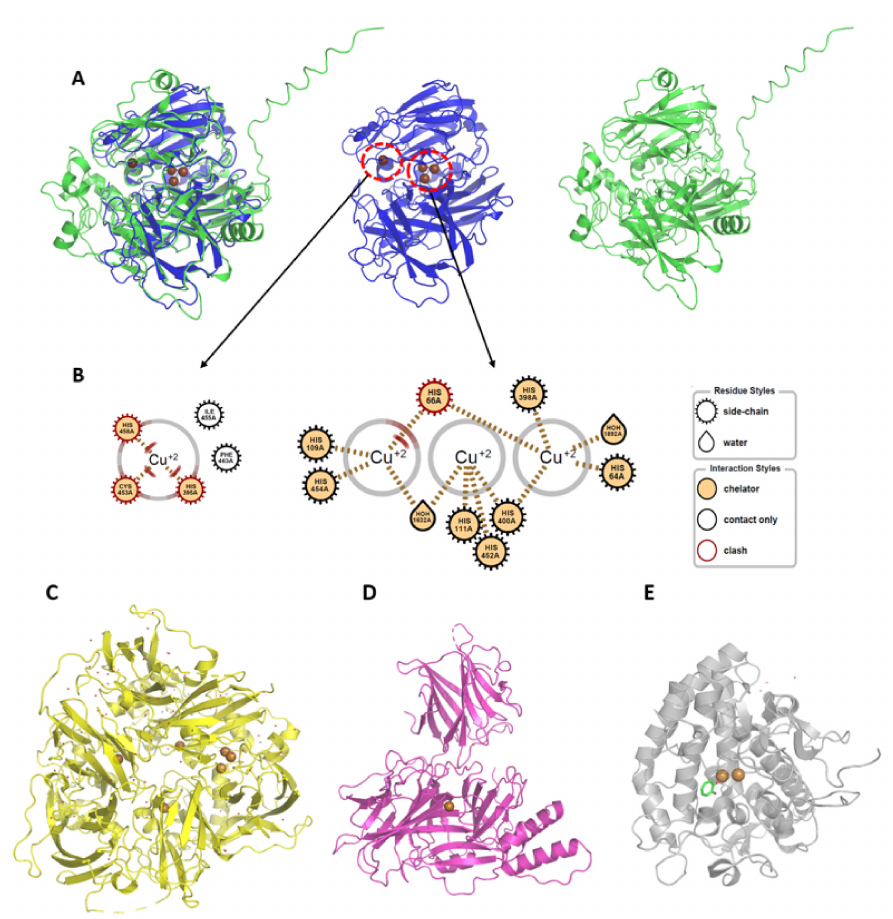
Figure 1. Structures of copper-containing metalloenzymes in this study. ( A ) Overlaid laccase struc- tures. Structures of T. versicolor (blue) and A. oryzae (green) laccases are overlaid. The PDB code for T. versicolor (center) is 1GYC, and the UniProt code for A. oryzae is I8U4Z0. AlphaFold [31] generated the structure for A. oryzae (right). Copper atoms are represented by brown spheres. ( B ) Catalytic metal-containing regions. The 2D diagram was prepared with Openeye Grapheme Toolkit. Two copper clusters (T1 (left), T2, and T3 (middle) sites) in T. versicolor are drawn with definition (right). ( C ) Ceruloplasmin, ( D ) dopamine- β -hydroxylase (DBH), ( E ) tyrosinase. The used PDB codes for ceruloplasmin, DBH, and mushroom tyrosinase are 4ENZ, 4ZEL, and 2Y9X, respectively. The brown spheres indicate copper atoms. Tropolone complexed in tyrosinase is shown with